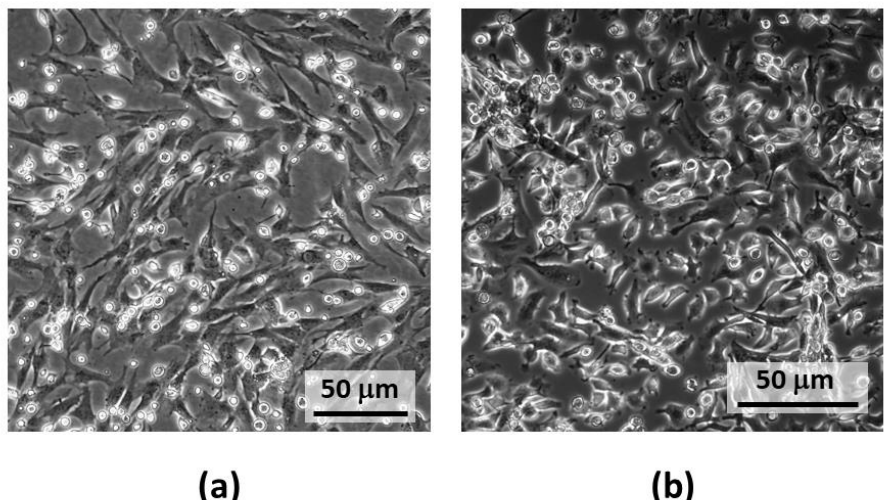
Figure A1. Representative images of the primary mouse ( a ) and rat ( b ) airway cell culture images 7 d after plating before the treatment with poly (I:C) and exosome collection. The cells on the bottom are fibroblasts, and the small cells organised in colonies on top of the fibroblasts are epithelial cells.